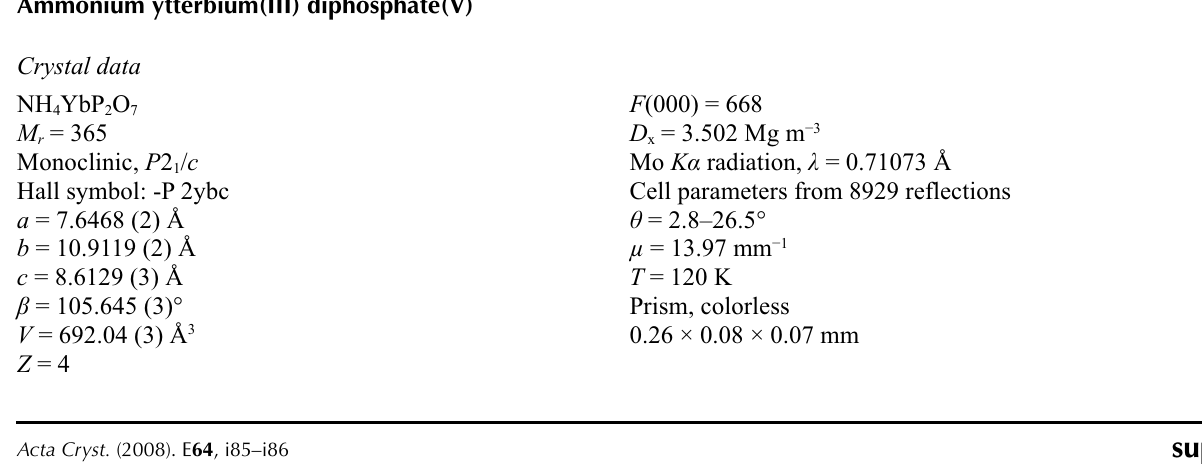
YbP O viewed along c . Colors: Pink (P 4 2 7